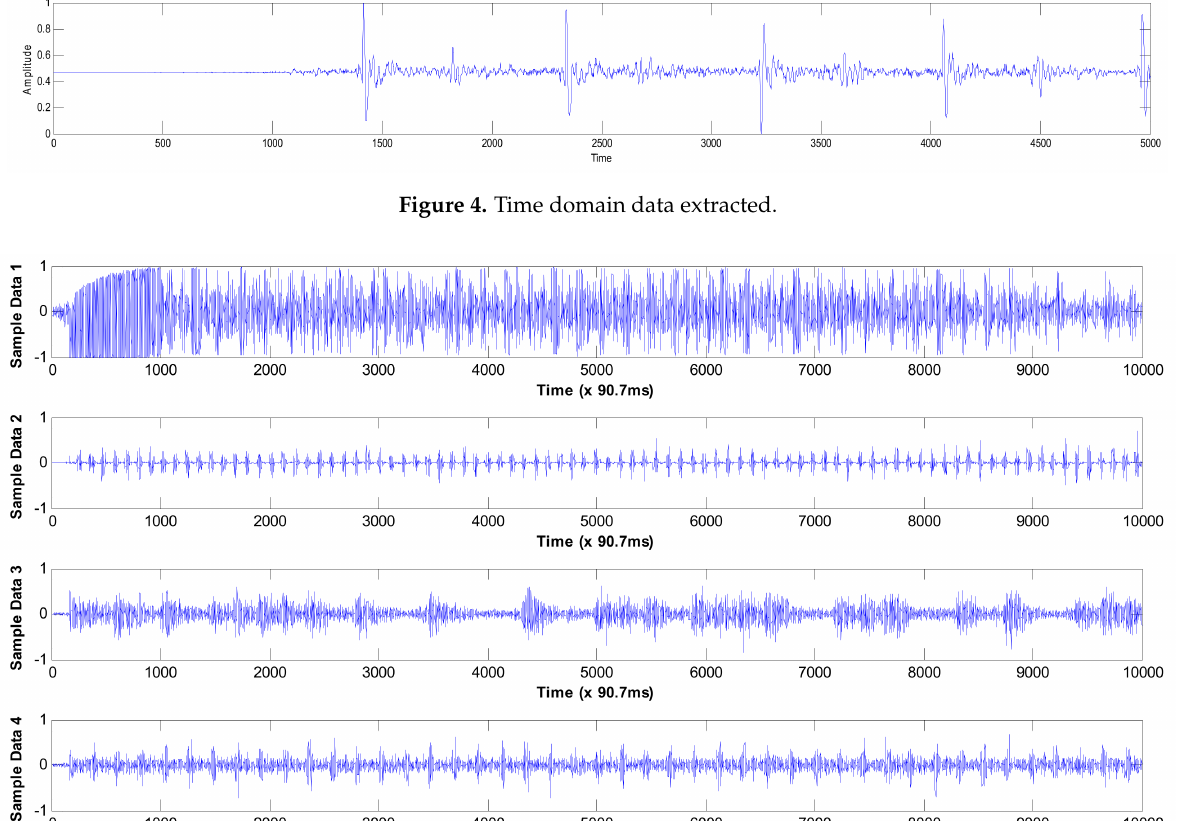
Figure 5. Final time domain data